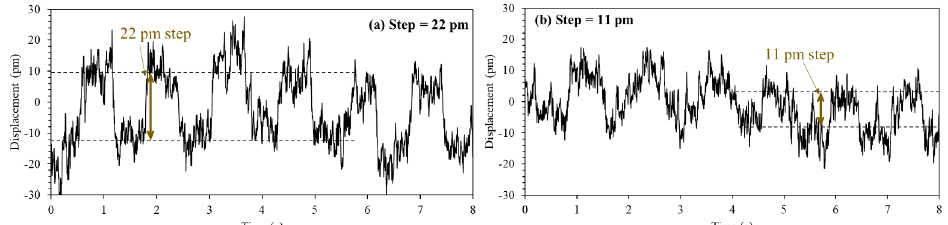
Figure 3. Step displacement measurement results obtained by the proposed system. (a) 22 pm step (0.44 mrad) and (b) 11 pm step (0.22